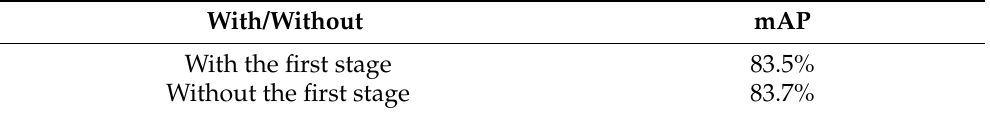
Table 4. The mAP with and without the first stage for difference maximum loss and focused feature enhancement.